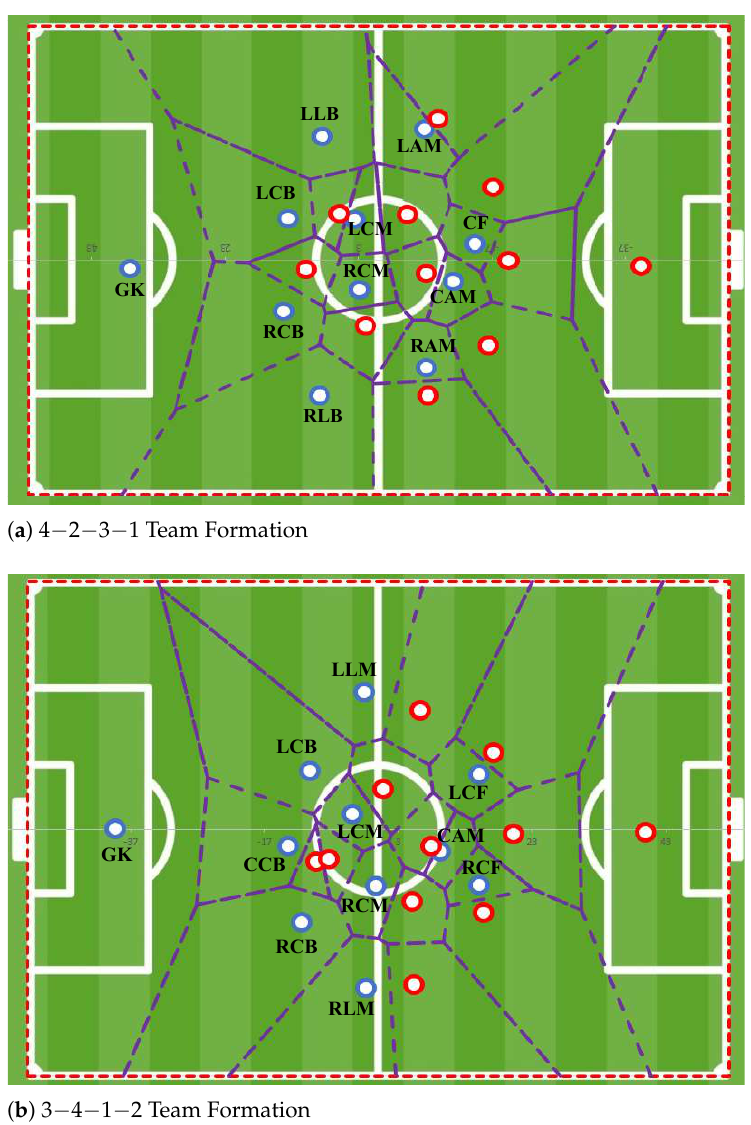
Figure 1. Voronoi diagrams for analysed teams (blue) in two team formations (( a ) 4-2-3-1 and ( b ) 3-4-1-2) and the opposing team